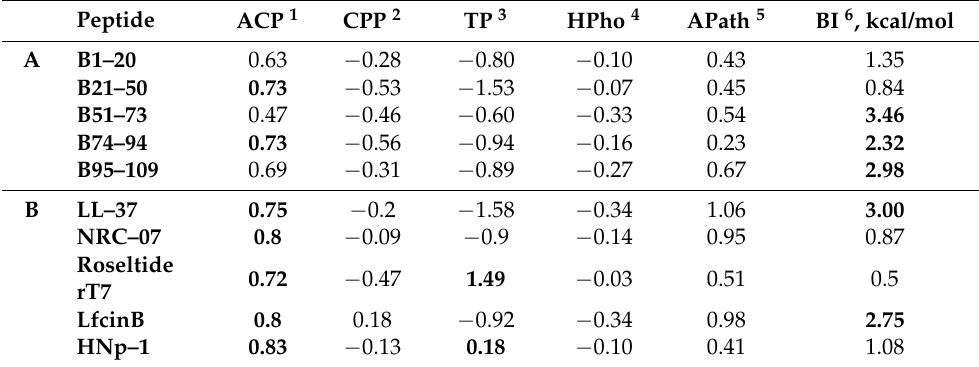
Table 2. Prediction of anticancer peptides (ACPs) properties of binase-derived peptides as compared to known anticancer peptides. Scores above the threshold are in